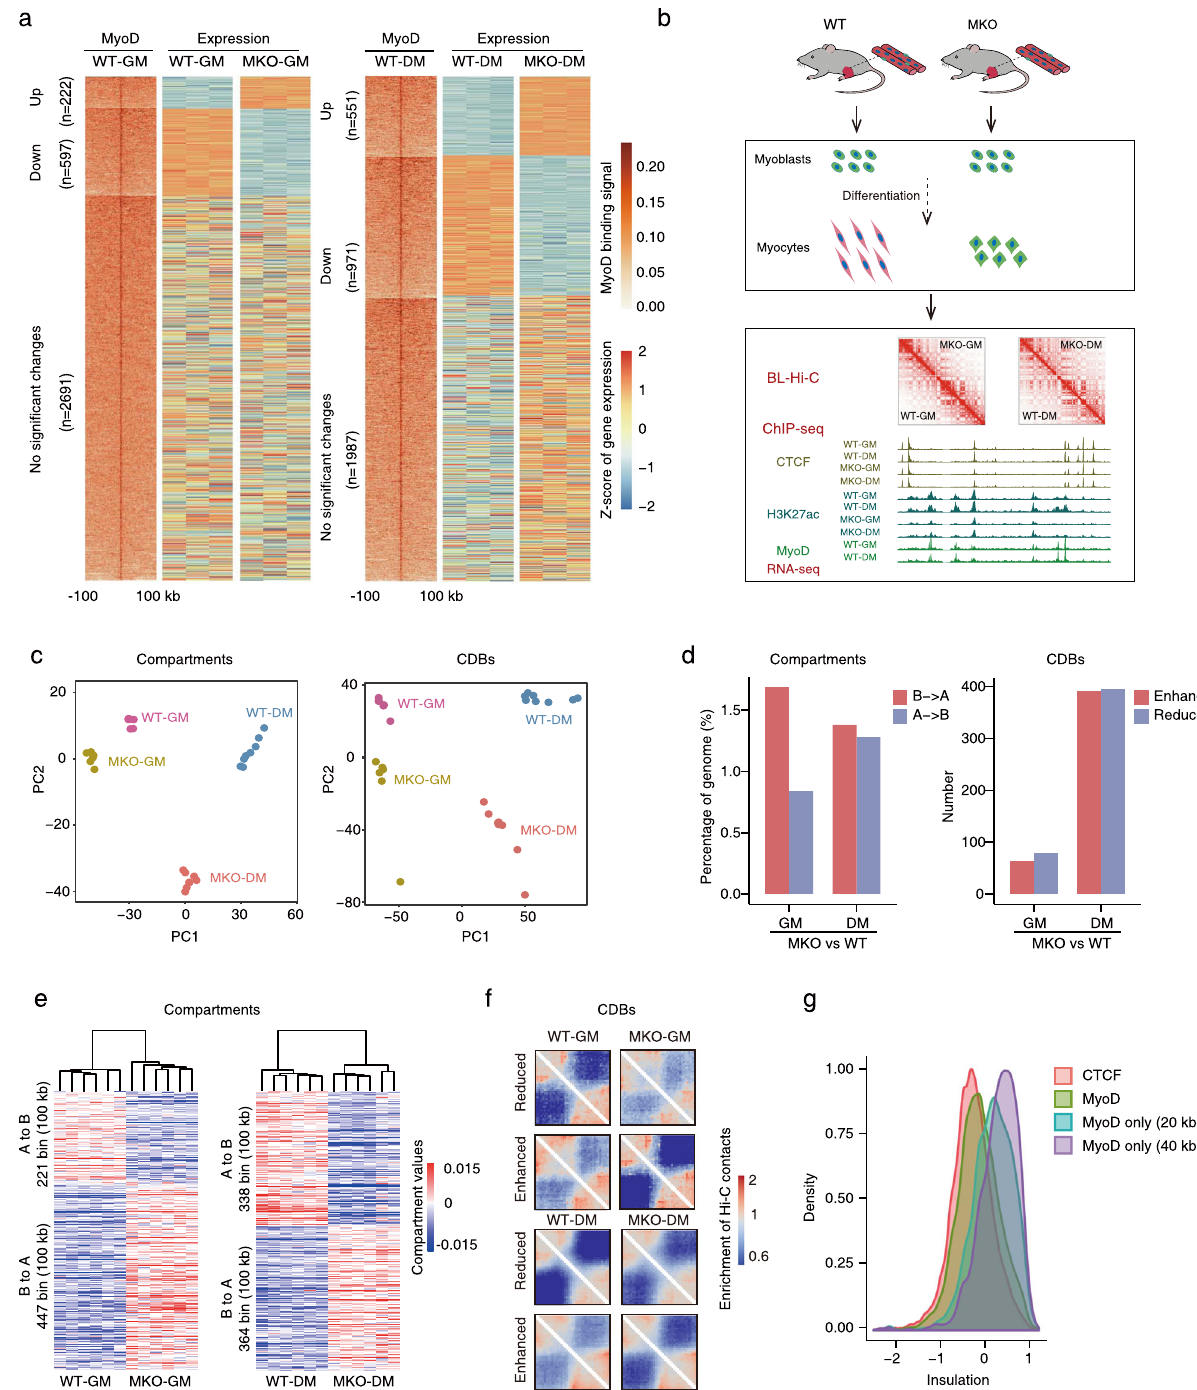
Fig. 1 MyoD regulates A/B compartment switching and contact domain boundary (CDB) formation in muscle cells. a Association of MyoD-binding peaks at promoter regions and related gene expression. Heatmaps show the MyoD-binding peaks at promoters (centralized at the TSS within 3 kb distance) and related gene expression trends in WT and MKO myoblasts (left panel). Corresponding data for WT and MKO myocytes is shown in the right panel. b Strategy for genetic investigation of the chromatin architectural roles of MyoD. c Principal Component Analysis (PCA) of the values of compartments or the relative insulation scores of contact domain boundaries (CDBs) among the four indicated sample types. Each dot represents an individual biological replicate. d Bar plots showing the percentage of A/B compartment shifts between WT and MKO myoblasts and myocytes (left panel). Bar plots showing the number of relative insulation-enhanced or -reduced CDBs between WT and MKO in proliferating and differentiating muscle stem cells (right panel). e Heatmaps of the A/B compartment-shifted regions between WT and MKO myoblasts and myocytes. f Hi-C aggregation plots centered at differential CDBs between WT and MKO myoblasts and myocytes. g Probability density of insulation score at genetic regions bound by CTCF or MyoD. Four classes were assessed: CTCF-bound; MyoD-bound; MyoD-bound; and CTCF-unbound within a 20 kb distance; and MyoD-bound and CTCF-unbound within a 40 kb